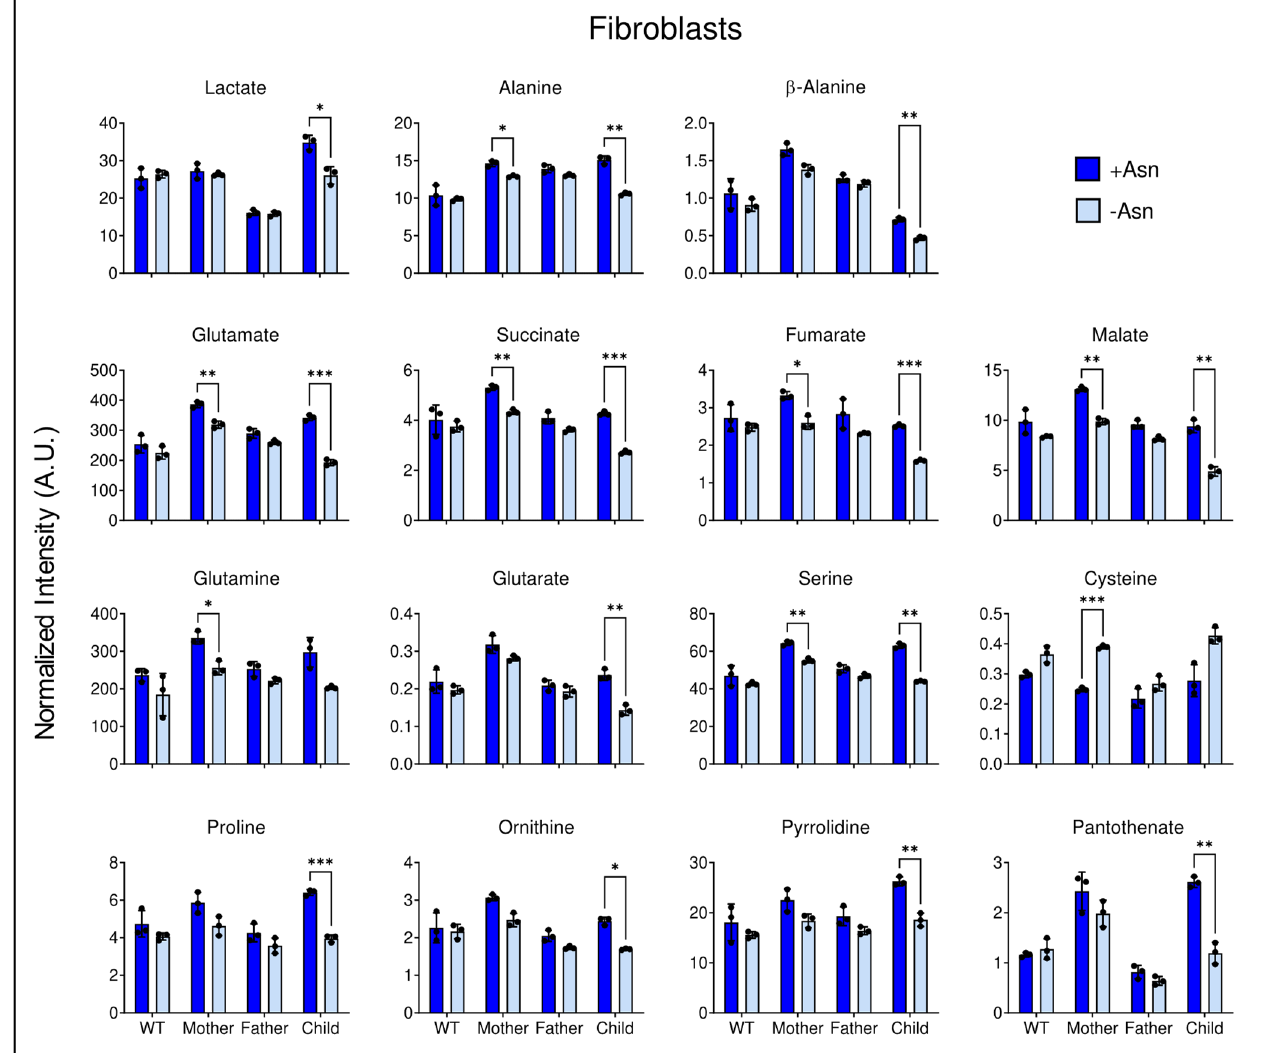
Figure 7. Differential metabolite levels between +Asn and − Asn groups in fibroblasts. Asn de- privation in ASNS-deficient cells leads to significant decrements in glycolytic products, TCA cycle intermediates, anaplerotic substrates, and amino acids. All cell lines were tested as N = 3 biological replicates and the data are shown as means ± SD. Statistical significance was established by two-way ANOVA analysis with Šidák multiple comparisons correction and is represented as: (*) if p ≤ 0.05,